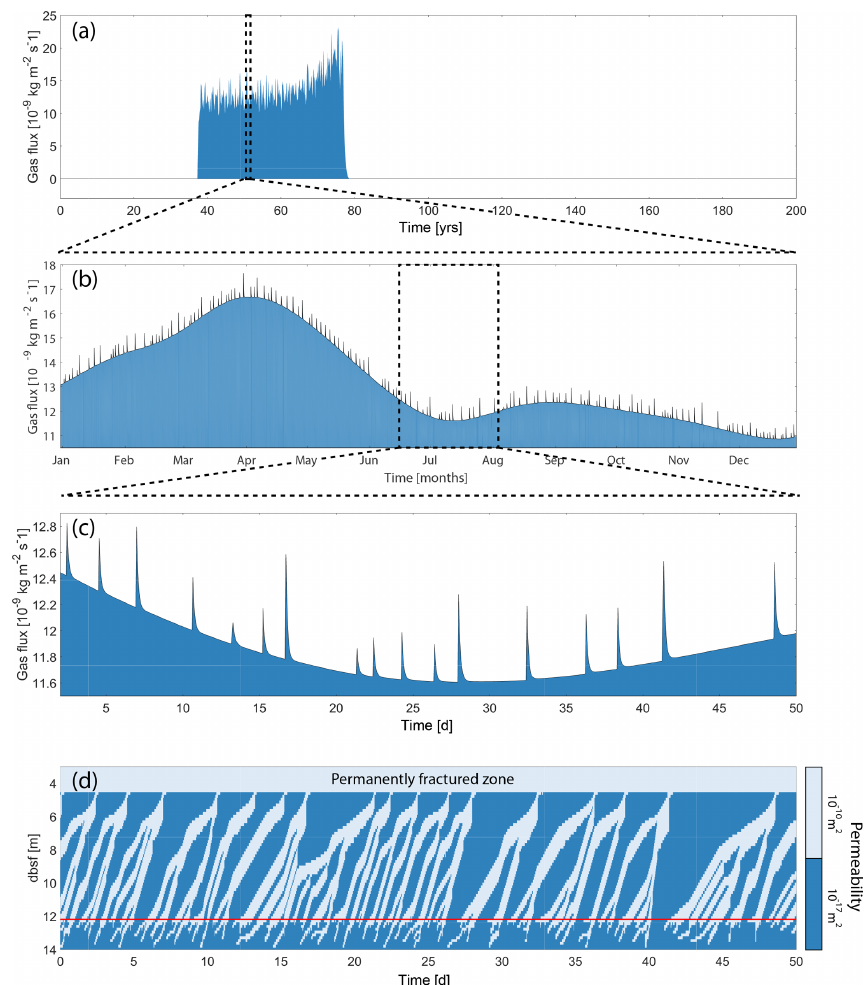
Figure 8. Fracture flow in low-permeability sediments for the base case simulation (Case A4 with permeability of 10 − 17 m 2 ). Seafloor gas flux for the whole simulation (a) , over 1 year (b) and over 50d (c) . (d) Fracture propagation within the sediments over the same period as panel (c) . The horizontal red line marks the upper boundary of the hydrate deposit at this particular time, and the permanently fractured zone is the upper part of the sediments where the presence of gas alone is enough to create fractures (see Stranne et al., 2017, for